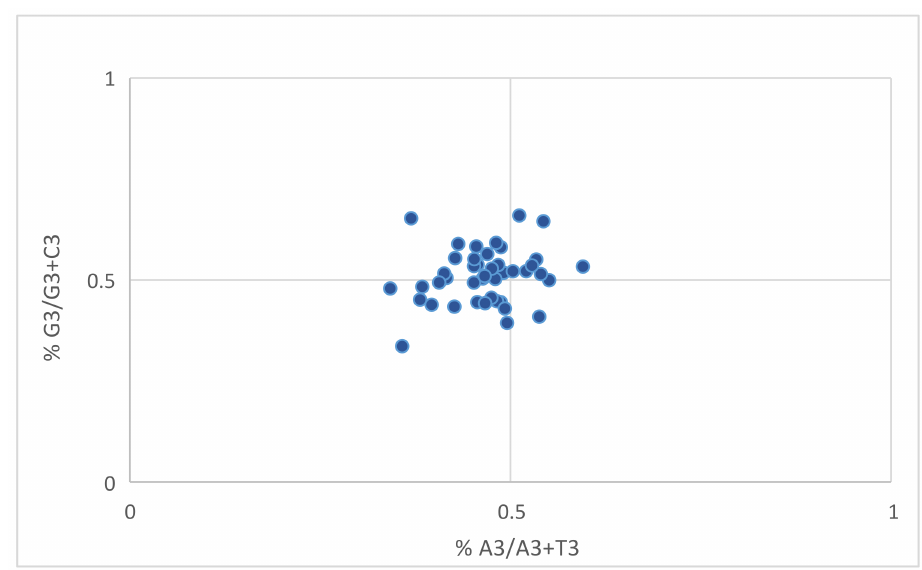
Figure 13. Parity plot analysis depicting preference of T and G over A and C.